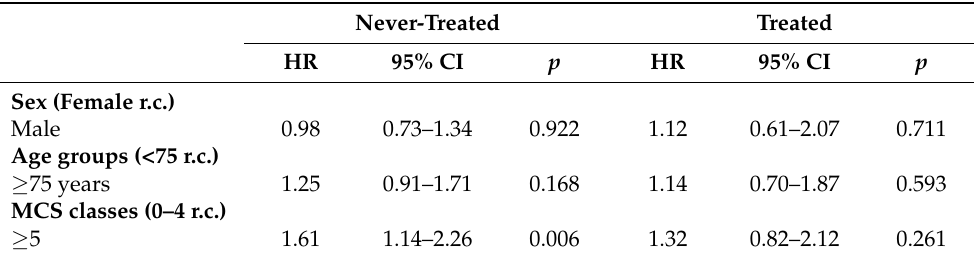
Table 2. Cox proportional hazard model for the risk of acute exacerbation. The analyses were stratified according to treatment.